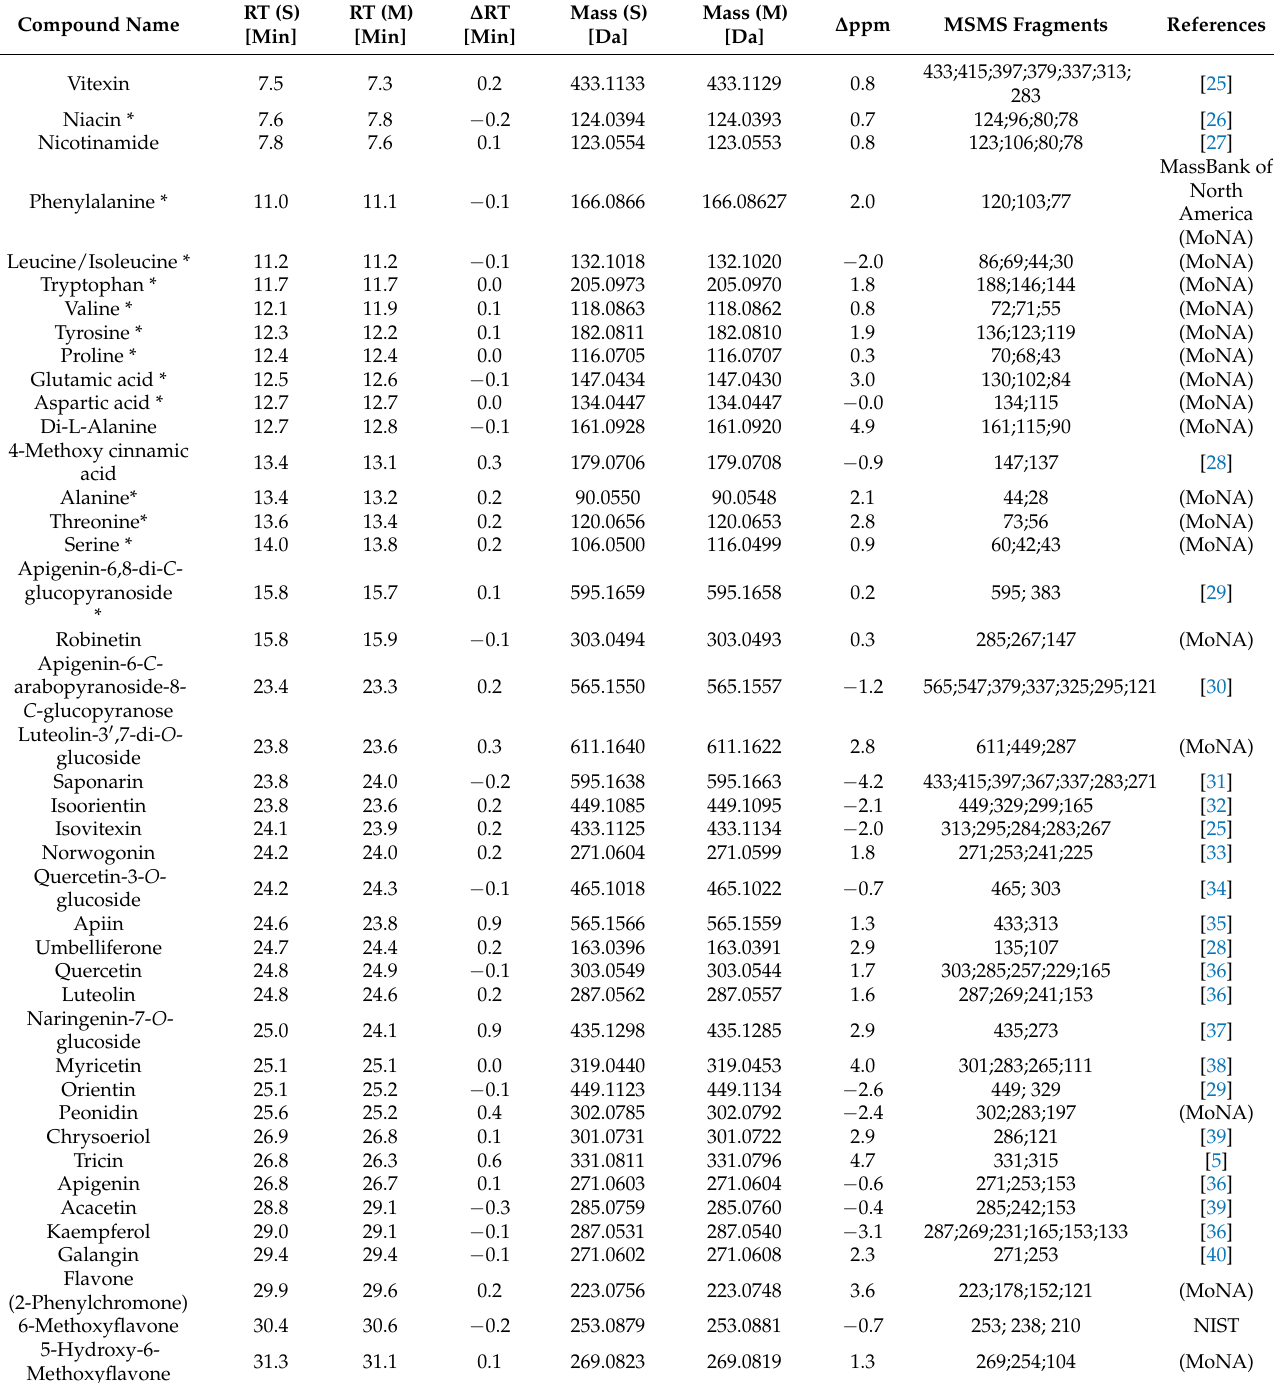
Table 1. Compounds identified in Lemna minor metabolic profile via PLANT-IDENT database. Retention time (RT) of standards (S), measured features (M), and the RT deviation, as well as the mass of standards (S), measured features (M), and the deviation between them, were listed. The mean fragments of standards and measured were compared with the literature and listed with the references; (*) means compounds detected in system A (single